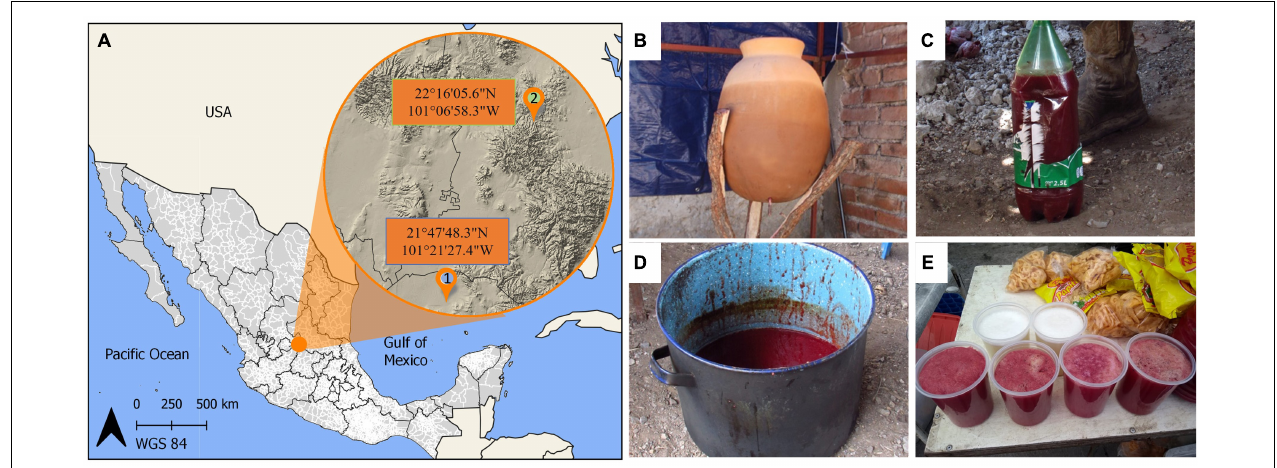
FIGURE 1 | Sampling sites and colonche samples (A1) the locality of Laguna de Guadalupe in Guanajuato state; (A2) , Mexquitic de Carmona in San Luis Potosí. (B) Claypots where spontaneous fermentation occurs; (C) Inoculum stored from the last season; (D) Cooked and boiled Cactus prickly pear fruits where sugars are concentrated; (E) Inoculated samples ready to sell in the local